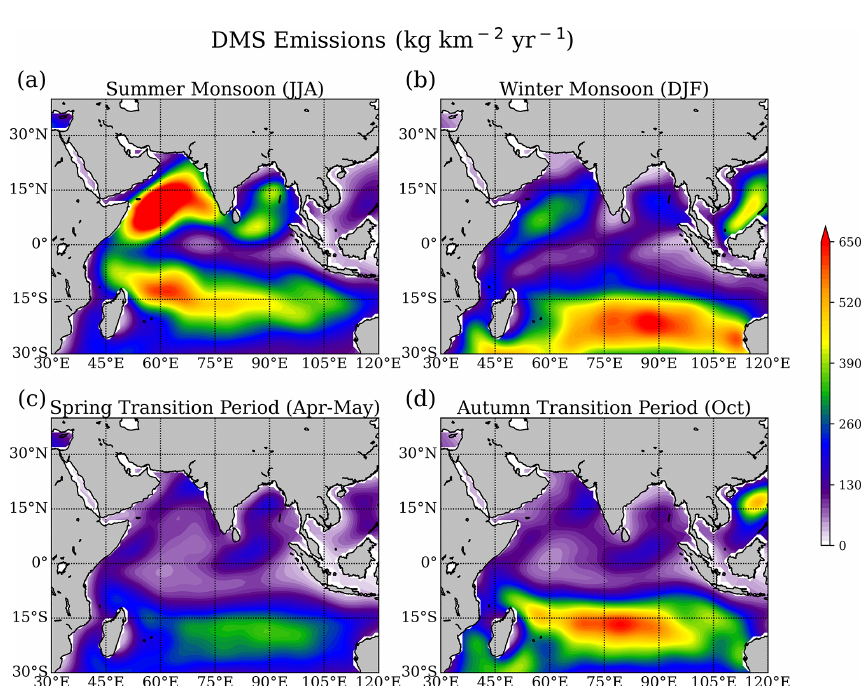
Figure 8. DMS emissions for (a) summer monsoon (June–August), (b) winter monsoon (December–February), (c) spring transition (April– May), and (d) autumn transition (October) from Lana et al. (2011).